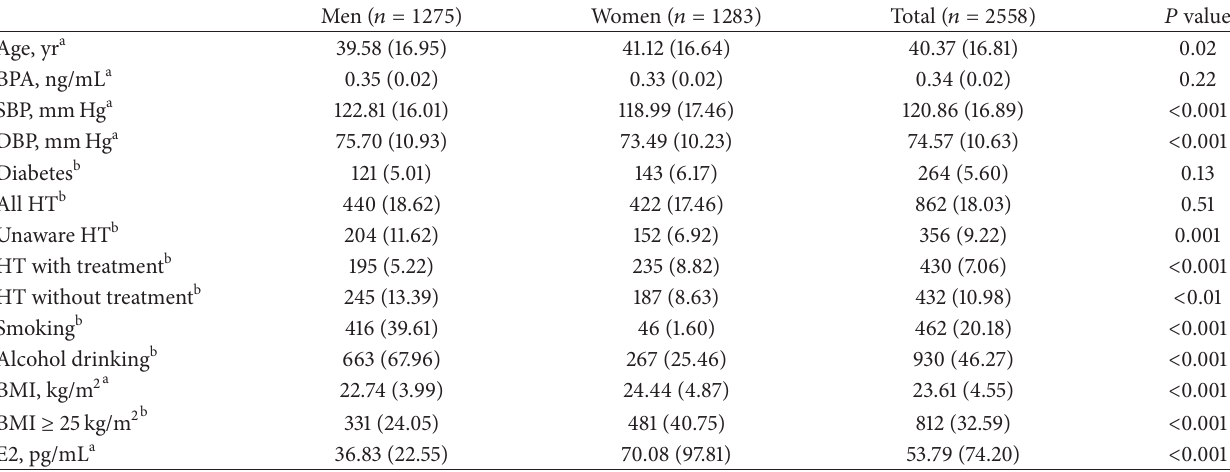
Table 1: Basic characteristics of the study samples.